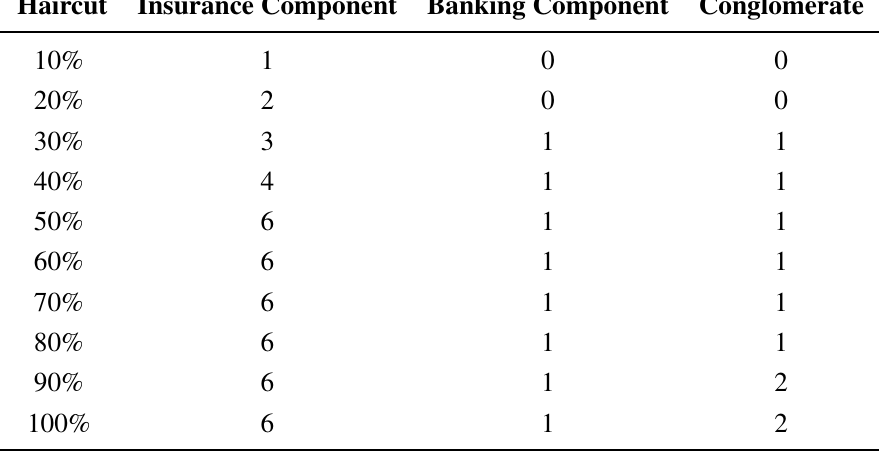
Table A2. Number of defaults for a shock on French sovereign debt: robustness check. When the French sovereign debt loses 40% of its value, four insurance components are in default, one banking component is in default and one conglomerate is in